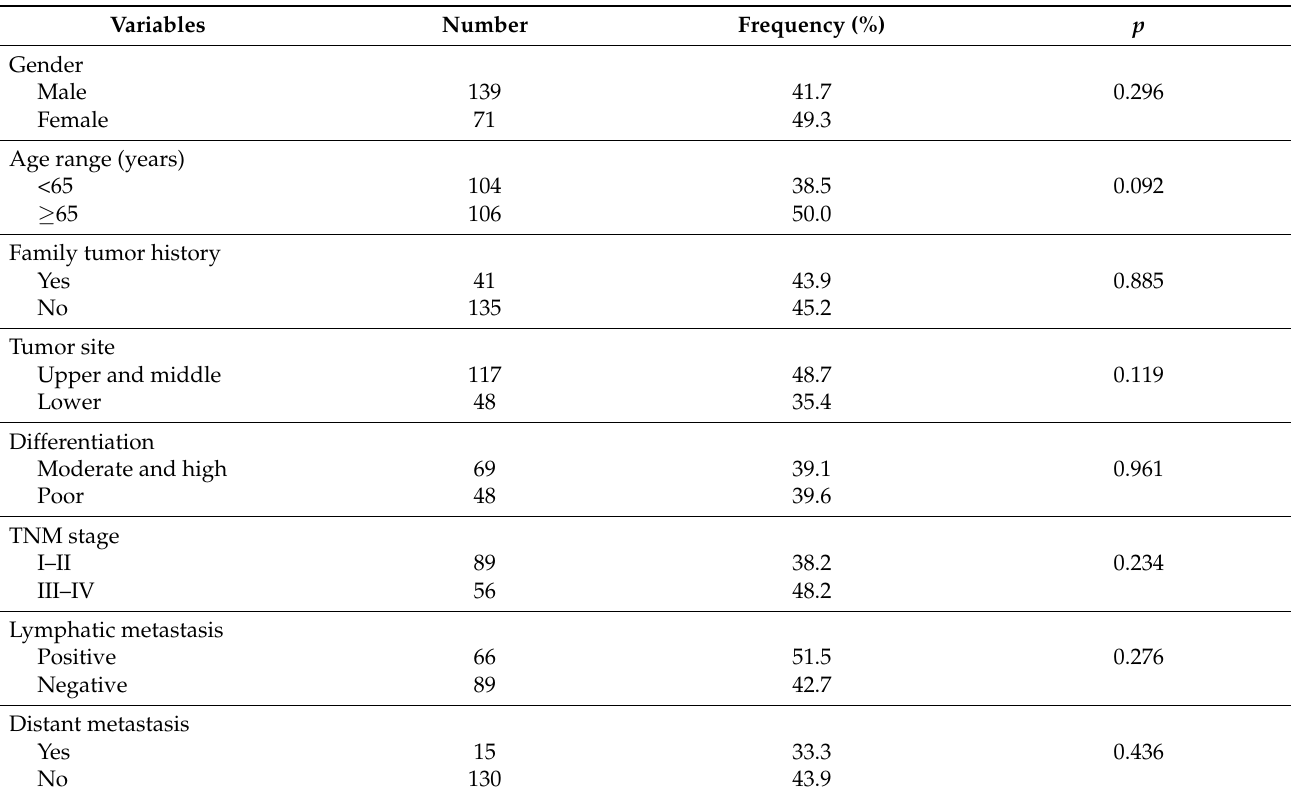
Table 4. The positive frequencies of anti-CXCL8 autoantibody in